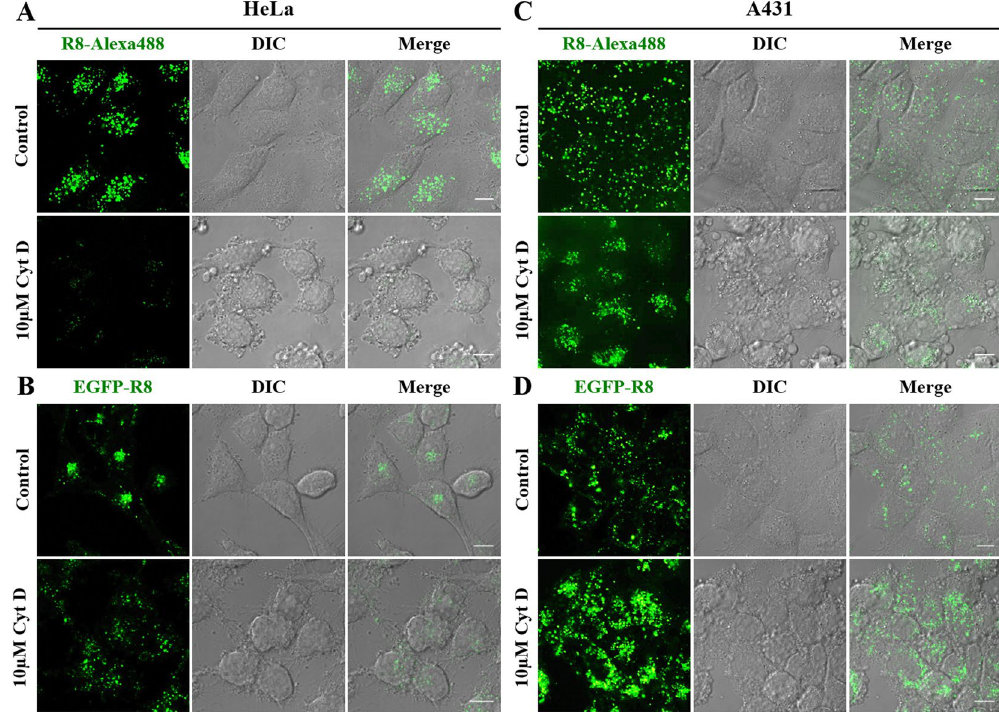
Figure 1. Cytochalasin D effects on the cellular uptake of R8 conjugates in HeLa or A431 cells. HeLa ( A,B ) or A431 ( C,D ) were preincubated with 10 µ M Cyt D or diluent control for 15 min prior to incubation with 2 µ M R8 conjugates (R8-Alexa 488, A , C , or EGFP-R8, B,D ) for 1 hr in the presence or absence of 10 µ M Cyt D before washing in heparin and analysis by confocal microscopy. Shown are single projection images of fluorescence only (R8-Alexa 488/EGFP-R8), DIC and merges of fluorescence and DIC of the same cells. Scale bars 10 µ m.